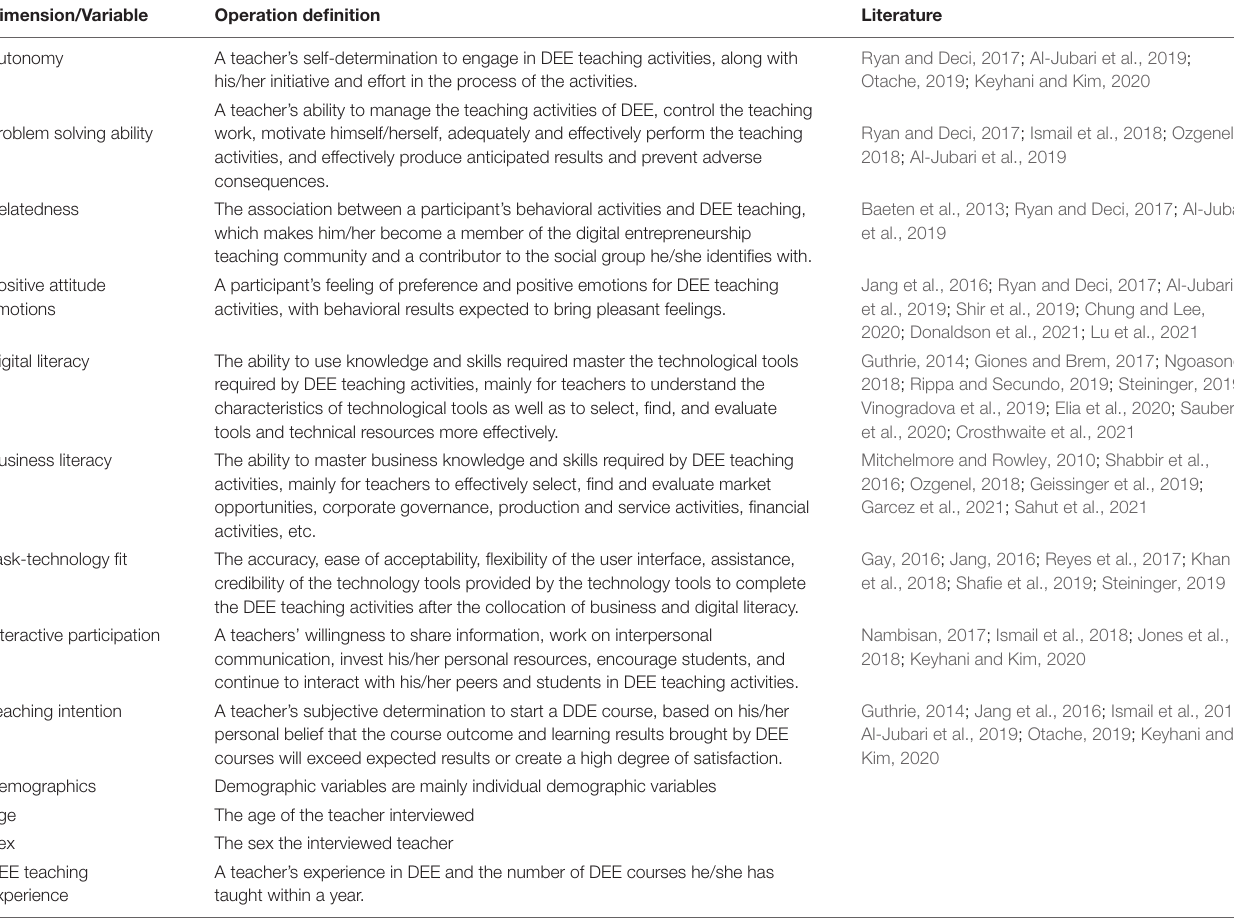
TABLE 2 | Operational definition of variables.